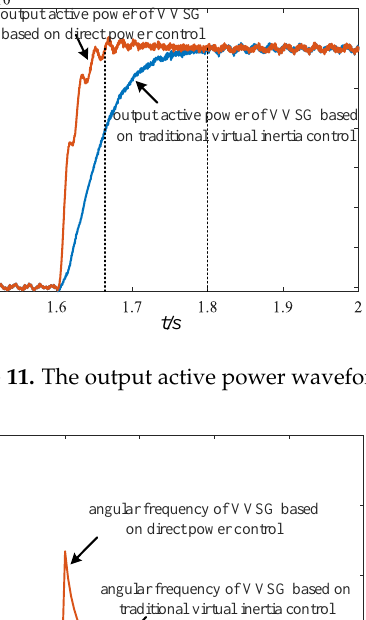
that it will not affect its active frequency support